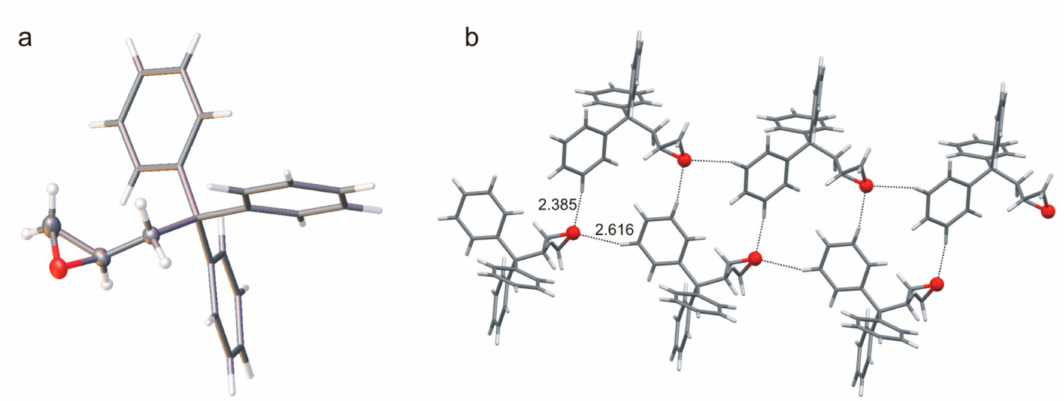
Figure 7. ( a ) Molecular structure of compound 11 and ( b ) intermolecular interaction in crystal structure. The oxygen atoms are shown as balls. The hydrogen bonds are shown as dashed